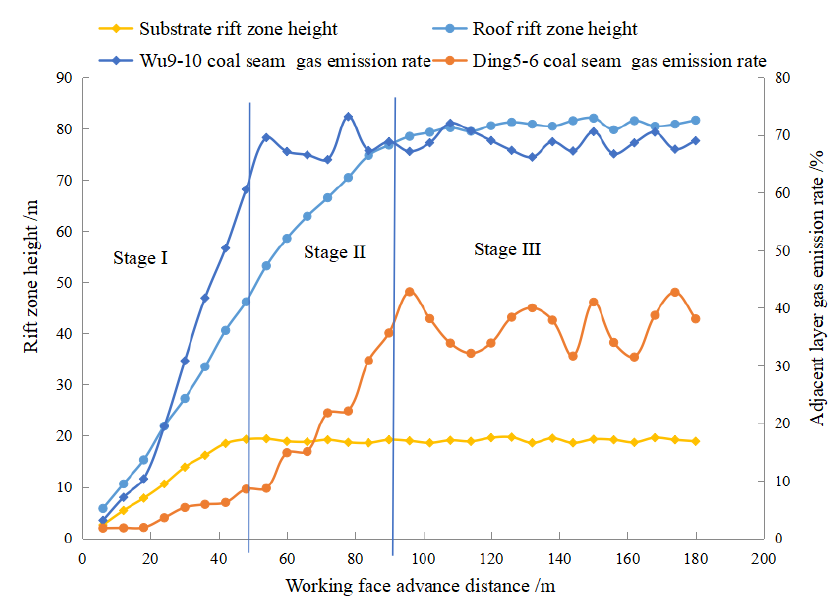
Figure 10. Variation of mining fracture zone height and gas emission rate of adjacent coal seams with the advancing distance of the working face.